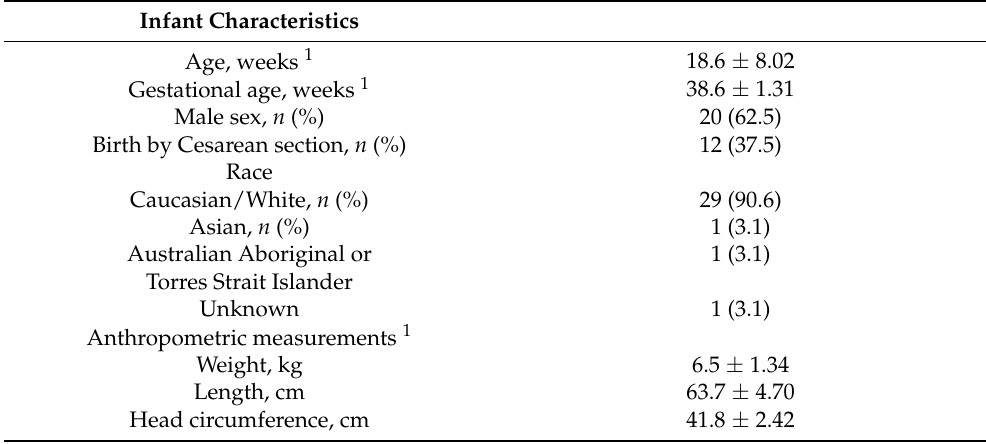
Table 1. Baseline characteristics of study participants who commenced treatment ( n =